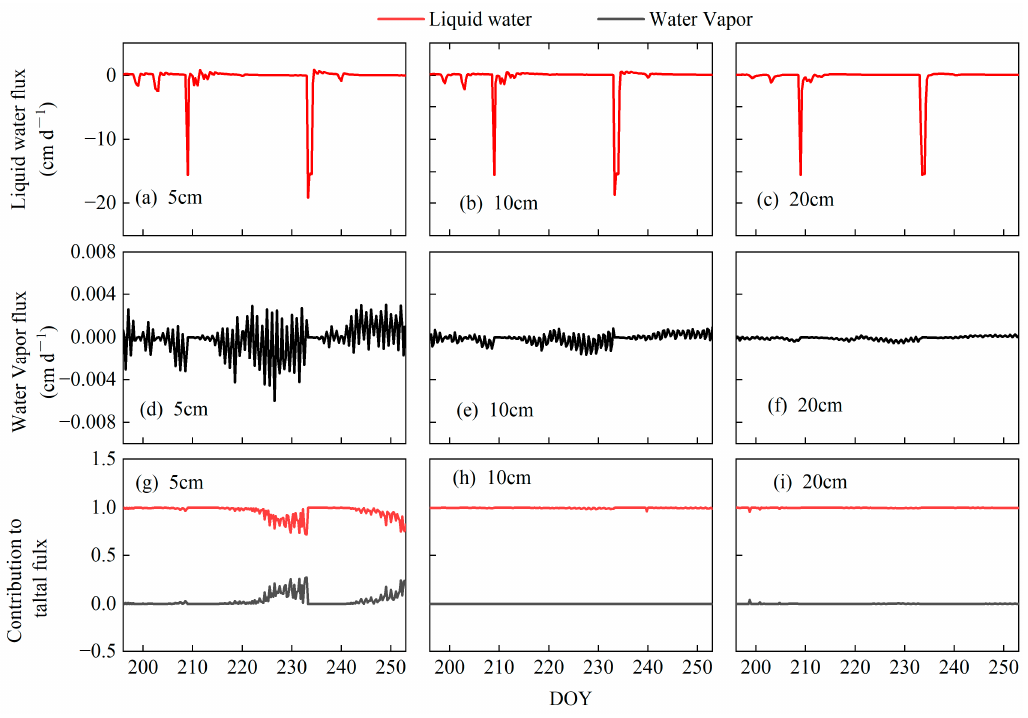
Figure 7. Liquid water and water vapor fluxes and their proportions at 5 cm ( a , d , g ), 10 cm ( b , e , h ) and 20 cm ( c , f , i ) for SMT. All fluxes are positive in the upward direction.